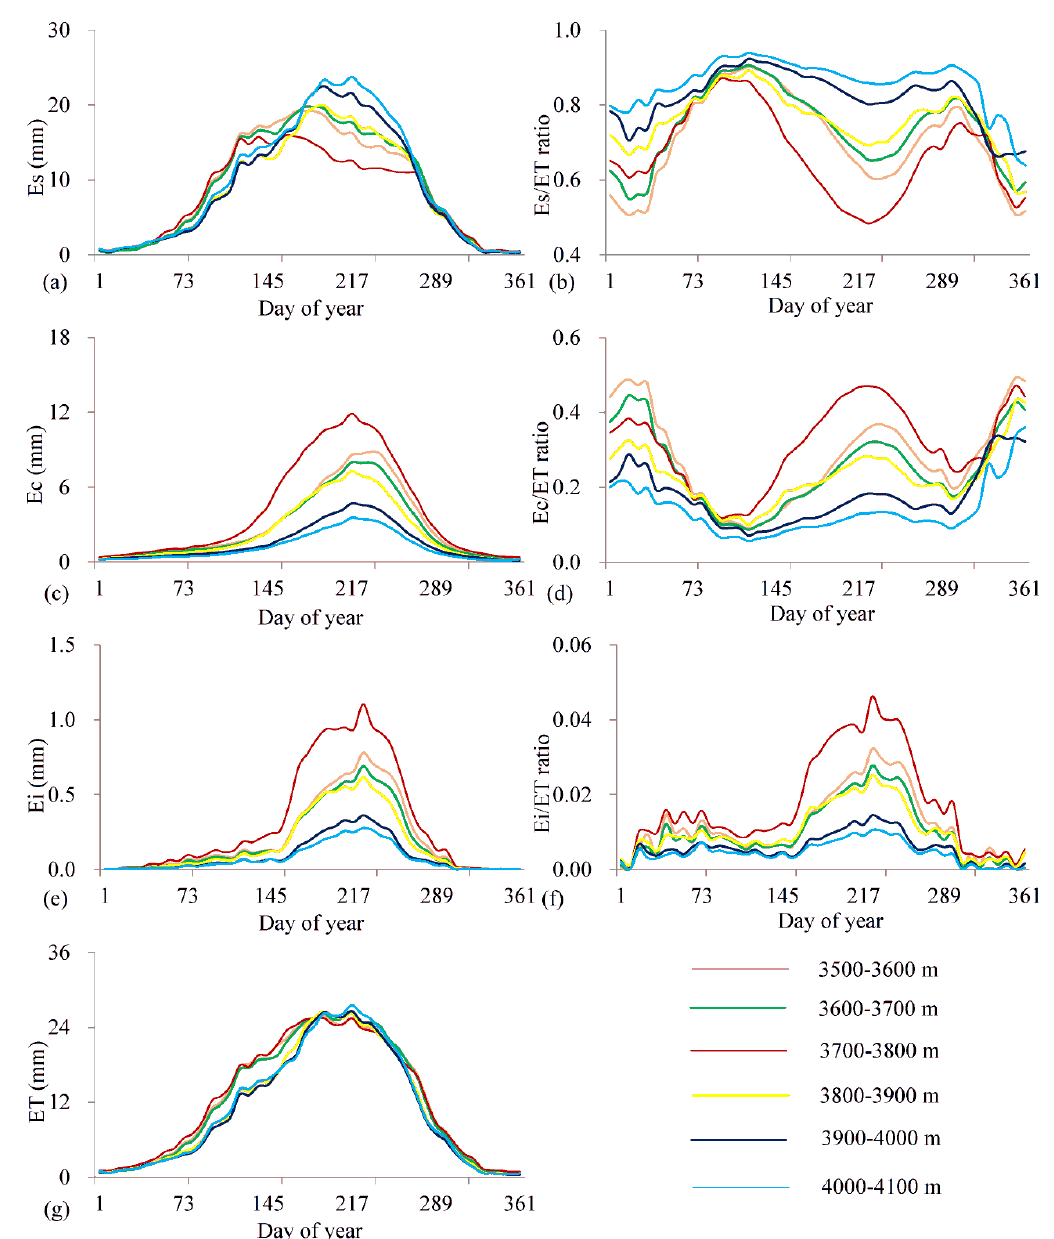
Figure 3. Temporal trends of Es( a ), Es/ET( b ), Ec( c ), Ec/ET( d ), Ei( e ), Ei/ET( f ), and ET( g ) of highland barley at different altitude zones.